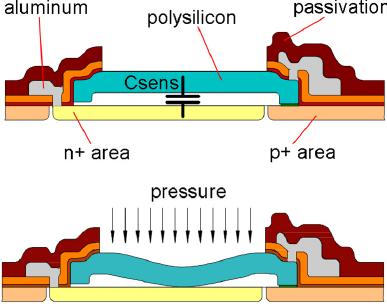
Figure 6. Cross-section SEM image of an area of the pressure sen- sor illustrating the difficult topography for